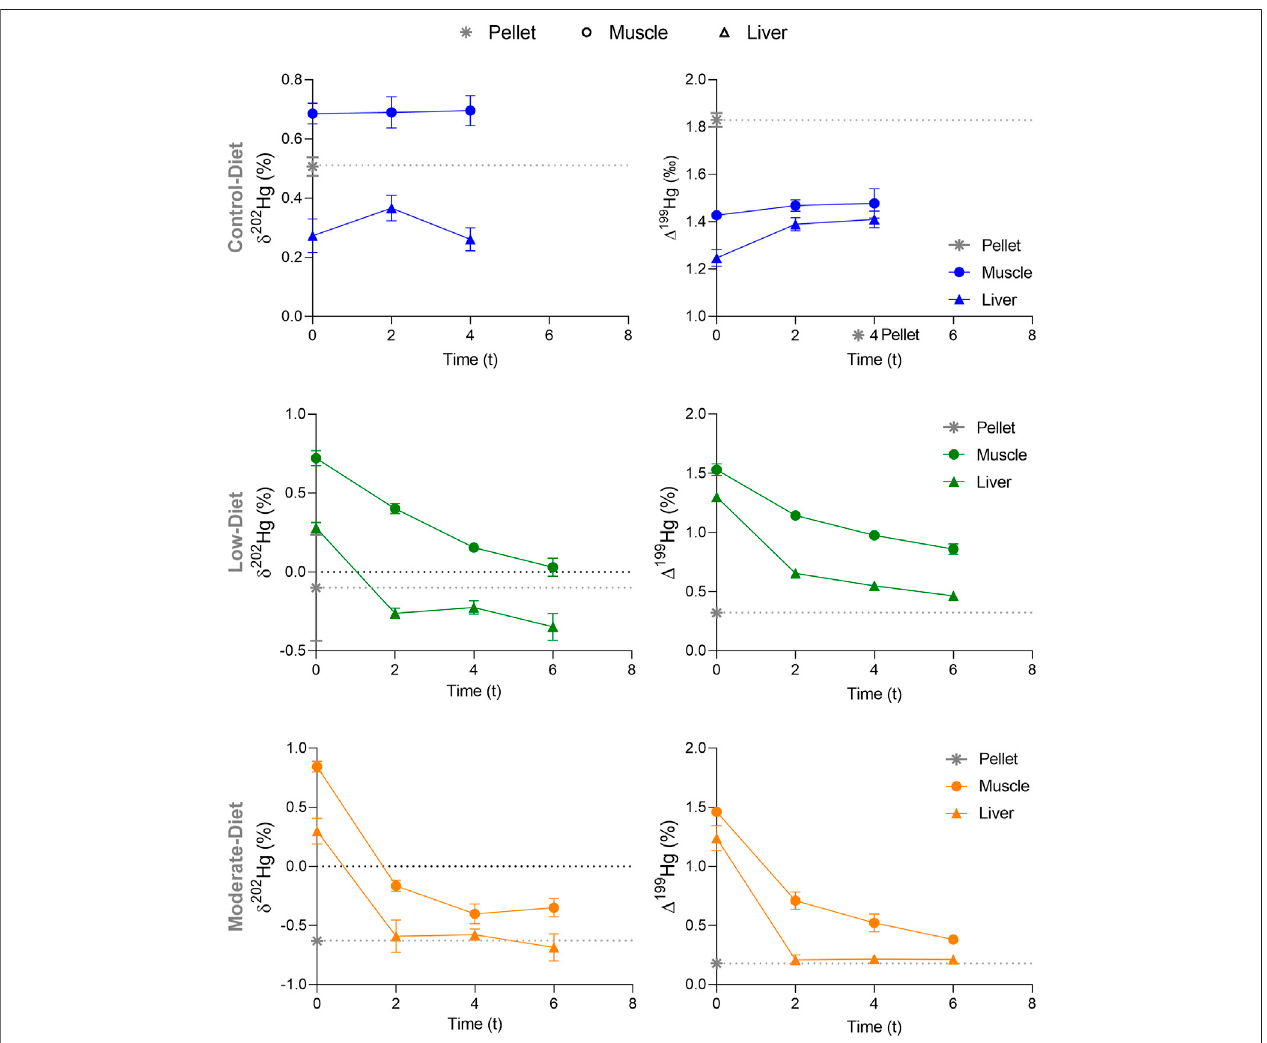
FIGURE 3 | Temporal variation of δ 202 Hg and Δ 199 Hg in muscle and liver of seabass Dicentrarchus labrax exposed to three distinct diets (Control in blue, Low in green,andModinorange)containingincreasingconcentrationinMeHg.Dataarerepresentedasmean±standarderror.Timeisexpressedas t ,indicatingthenumberof weeks from the beginning of the experiment, after the acclimation period. The gray asterisk and gray dotted line represent the MeHg and iHg concentrations in the Control diet (pellet) at t 0 .